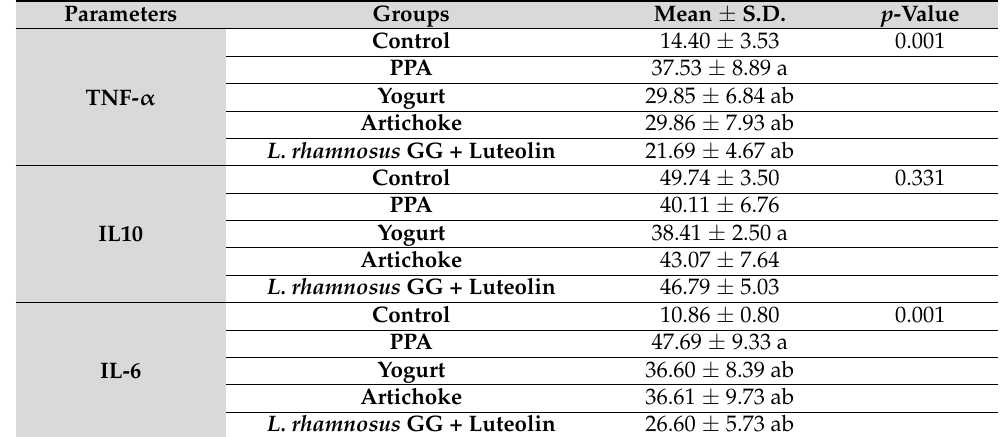
Figure 2. The percentage change in TNF ‐α , IL10, and IL ‐ 6 levels in the brain homogenates of an untreated PPA ‐ induced autism model and nutritionally treated groups of yogurt, artichokes, and combined L. rhamnosus GG + luteolin relative to the control, presented as 100%. 2.2. Effect of the Nutritional Interventions on the Levels of TNF ‐α , IL ‐ 10, and IL ‐ 6 as Neuroinflammatory Markers Table 2 and Figure 2 demonstrate the levels of TNF ‐α , IL ‐ 10, and IL ‐ 6 in the five stud ‐ ied groups. PPA treatment induced a highly significant increase in TNF ‐α and IL ‐ 6 as pro ‐ inflammatory cytokines, recording percentage increases of 196.81% and 482.8%, respec ‐ tively, compared to the control group of rats. IL ‐ 10, as an anti ‐ inflammatory cytokine, was significantly lower in the PPA ‐ treated group and did not increase after nutritional inter ‐ ventions. Yogurt, artichoke, and L. rhamnosus GG + luteolin treatments demonstrated sig ‐ nificantly lower levels of TNF ‐α and IL ‐ 6 compared to the PPA ‐ treated group, but these levels were still remarkably higher than in the controls. The L. rhamnosus GG + luteolin ‐ treated group recorded the lowest values of both pro ‐ inflammatory cytokines.